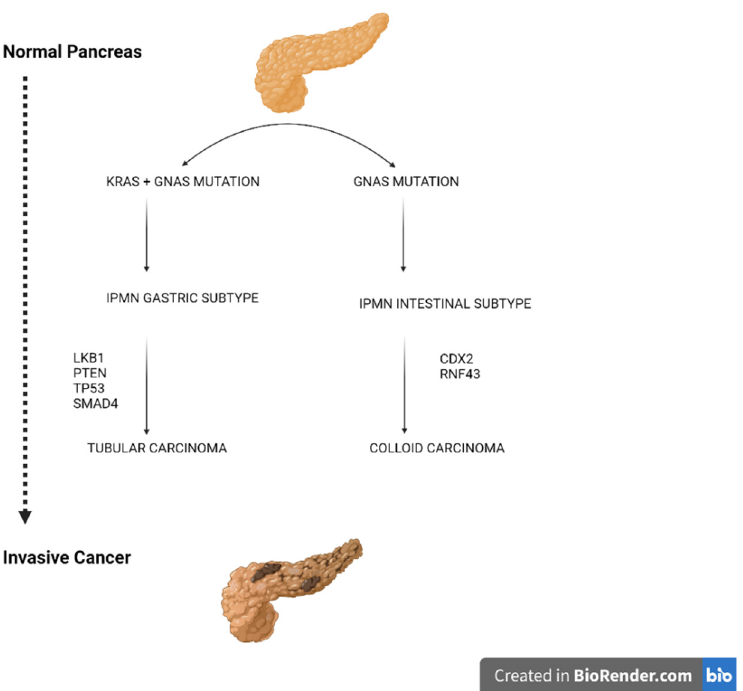
Figure 2. Hypothetic pathways of progression from the normal pancreas to intestinal or gastric IPMN and degeneration to pancreatic cancer.